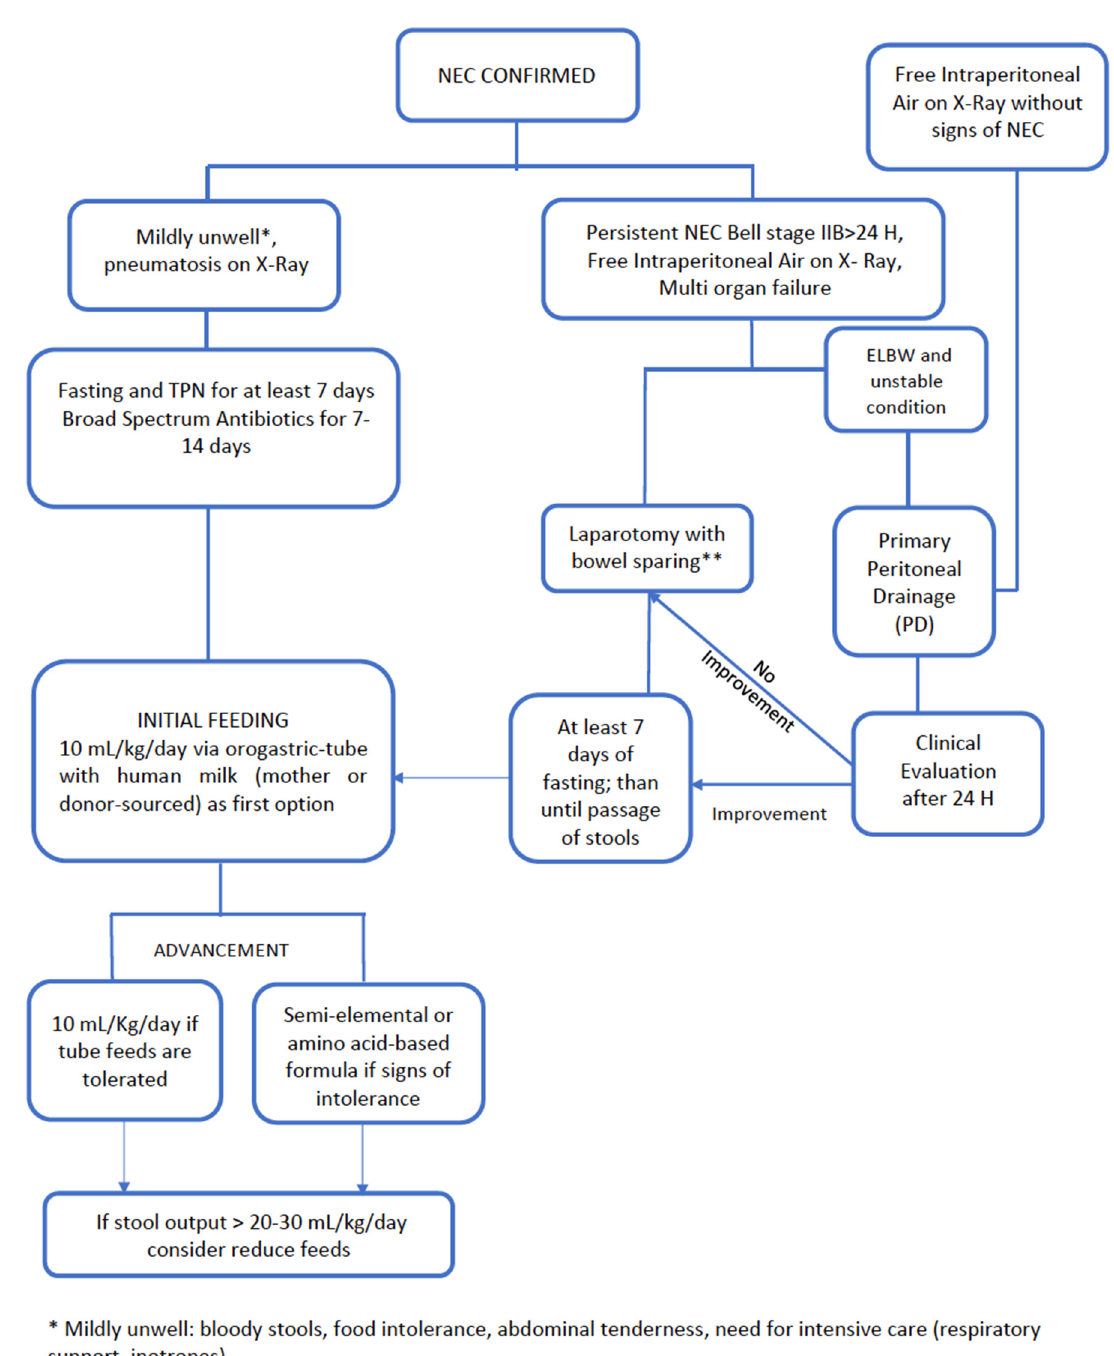
Figure 2. Our center Policy for infants with NEC.